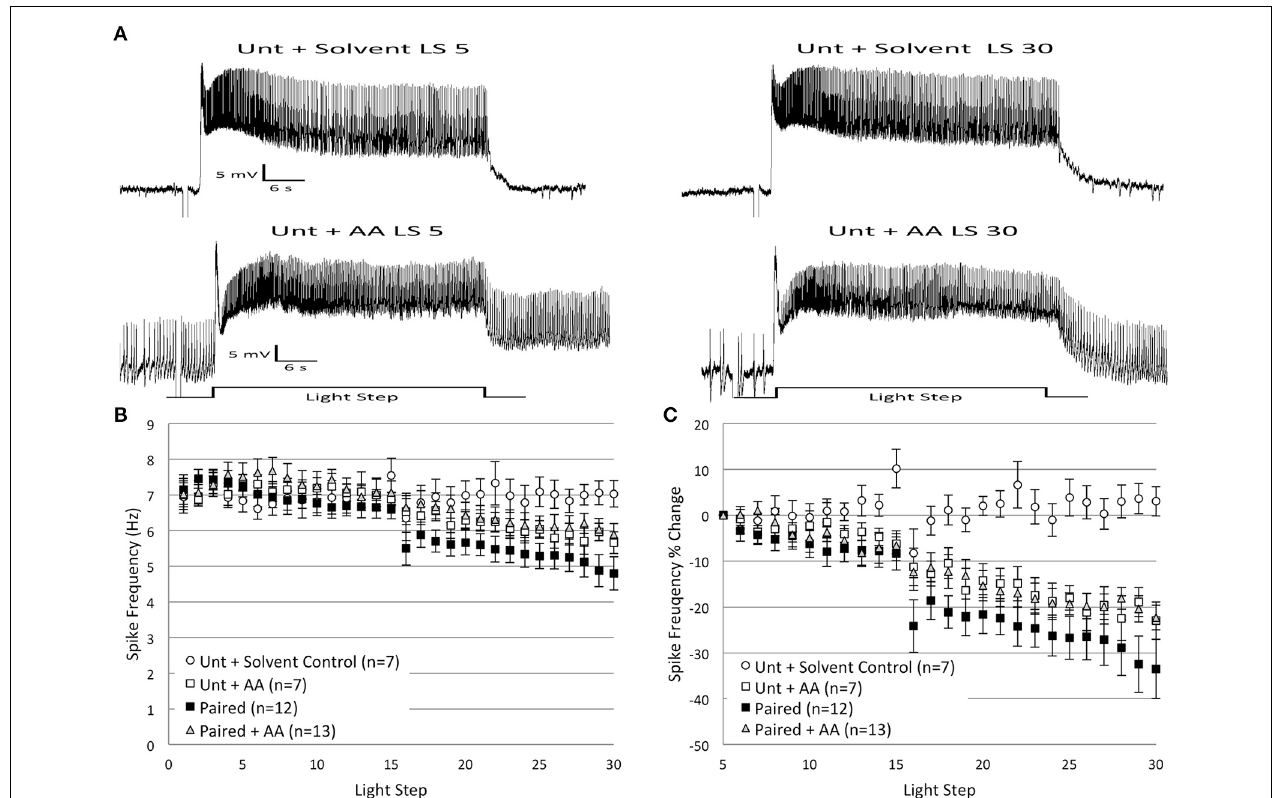
FIGURE 9 | Bath application of arachidonic acid (AA; 100 µ M) onto Paired Type B cells reduced B cell spike frequency and occluded any further decreases produced by in vitro extinction. AA applied to Untrained B cells produced reductions in spike frequency that mimicked the decreases observed in Paired (no drug) cells. AA or vehicle solvent (ethanol, 0.1% final bath concentration) was bath applied to exposed H.c. nervous systems immediately after the 5th LS. (A) Representative light responses recorded from an Untrained Type B cell exposed to solvent ( Unt + Solvent ; top trace) or AA ( Unt + AA ; bottom trace). (B) Summary spike frequency data of Type B cells exposed to AA or solvent over 30 LSs. Paired + AA cells exhibited a decrease in spike frequency compared to Unt + Solvent control cells (significant interaction between LS and condition). The significant reduction in spike frequencies produced in Paired + AA cells was as large, but no larger, than the decrease produced in